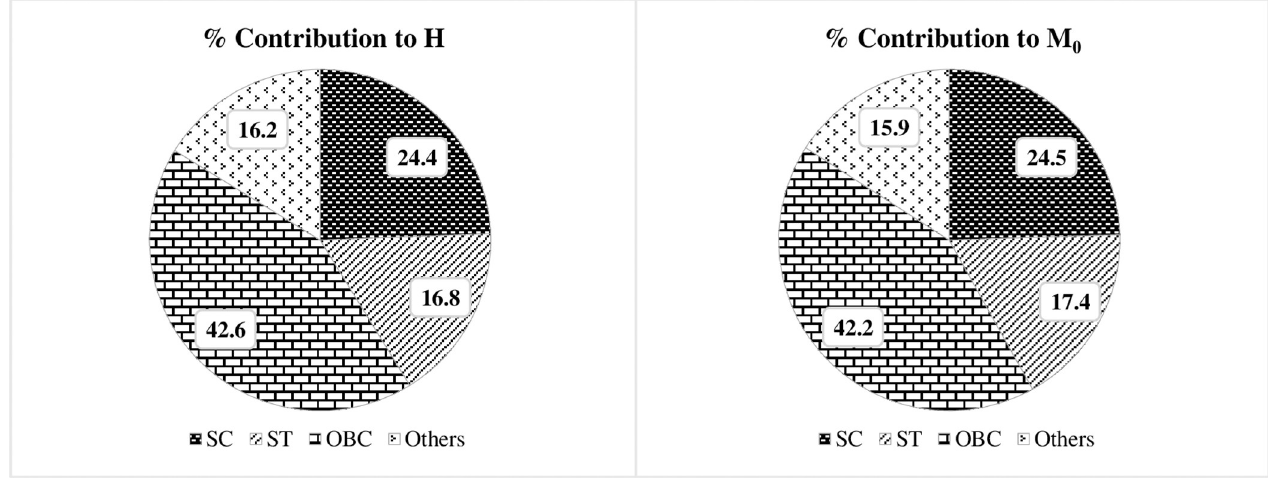
Fig 2. Social group-wise contribution to headcount ratio (H) and adjusted headcount ratio (M 0 ).